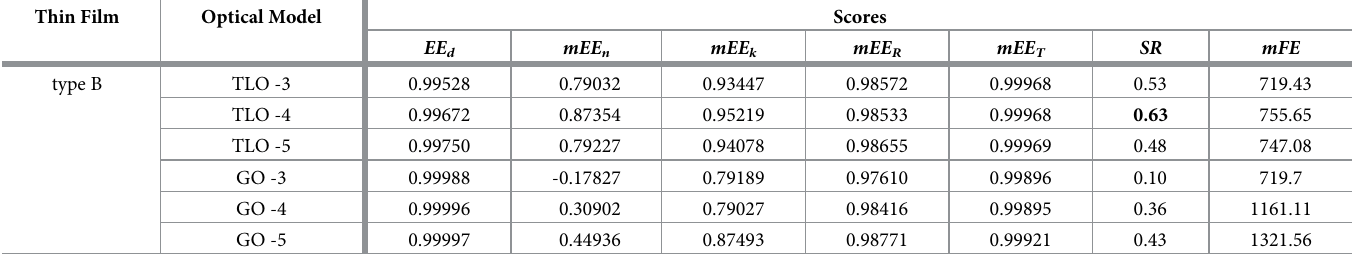
Table 4. Estimation performance of the adopted oscillator ensemble models applied on 100 samples of type B films, picked randomly from the semi-synthetic data- set. Note that the spectral data are in consistent with linear spectrophotometric measurements. Thin